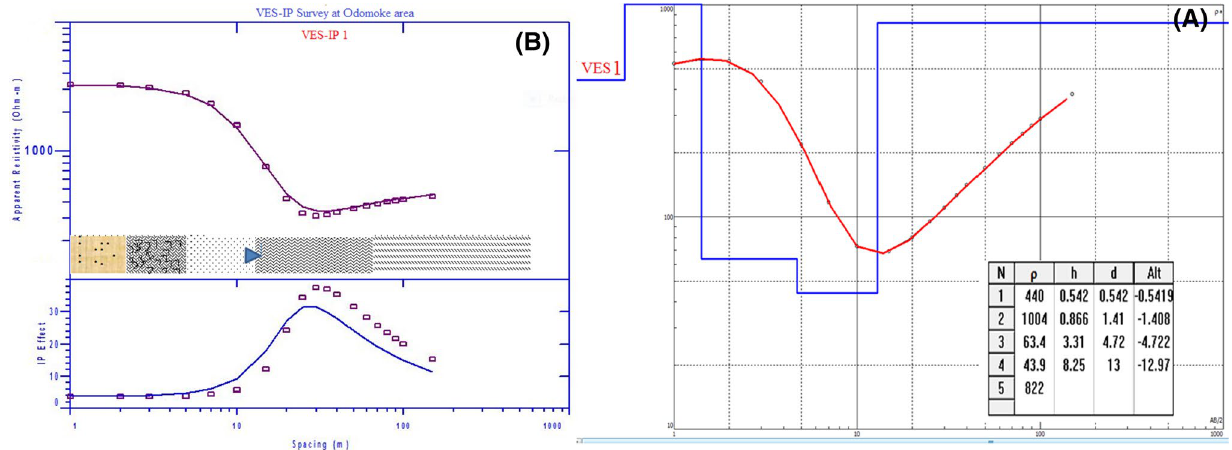
Fig. 3 a Geoelectric units for VES 1 (Odomoke area) with apparent resistivity curve (inset table shows layer resistivities and depths); b VES-IP curves juxtaposed with adjacent borehole (BH 3) data from Odomoke